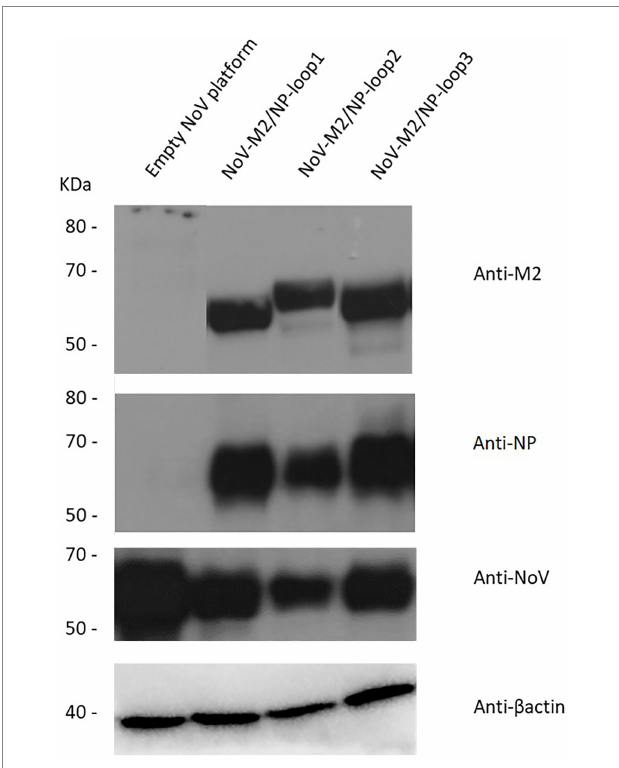
FIGURE 3 Characterization of the chimeric NoV-M2/NP proteins. Western blotting analysis of different chimeric NoV-M2/NP proteins expressed in the SF9 insect cells in reducing conditions. The protein was detected as a ~ 65 kDa band in culture media using monoclonal anti-M2 antibodies, monoclonal anti-NP antibodies, and anti-VP1-NoV antibodies. β -actin was used as a loading control. Culture media from cells expressing unmodified NoV protein (empty platform) was used as a negative